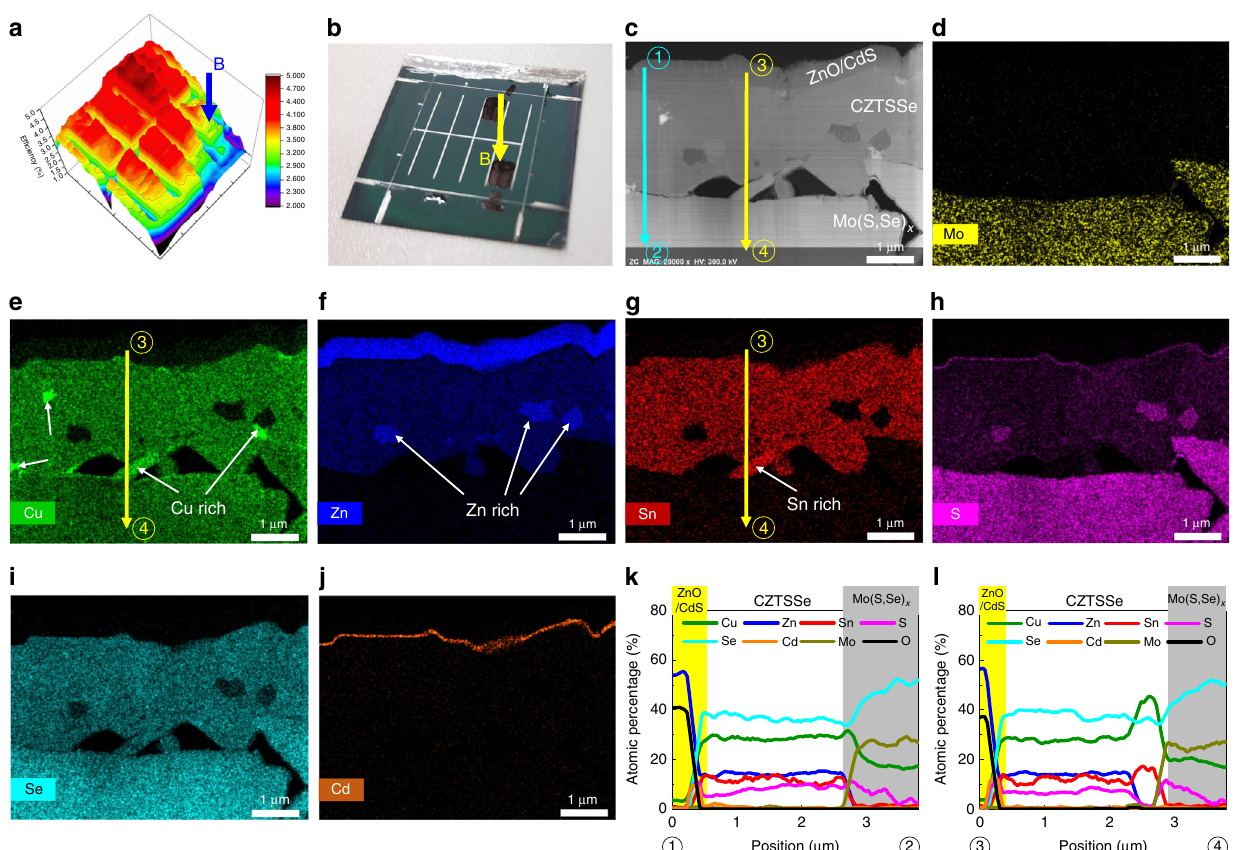
Fig. 6 STEM-EDS mapping images of point B of fl exible CZTSSe3-L. a Ef fi ciency mapping image using MIV measurements. b Real sample image. c Cross- sectional STEM image. EDS mapping images of the CZTSSe3-L absorber layer showing mappings of d Mo, e Cu, f Zn, g Sn, h S, i Se, and j Cd. The elemental variations across vertical and lateral directions in the STEM images ( c ) were measured using EDS line scans. k EDS line scan of ① → ② . l EDS line scan of ③ →